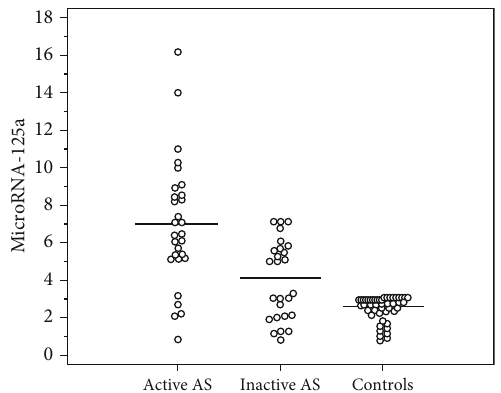
Figure 1: Comparison between the three studied groups according to microRNA-125a.